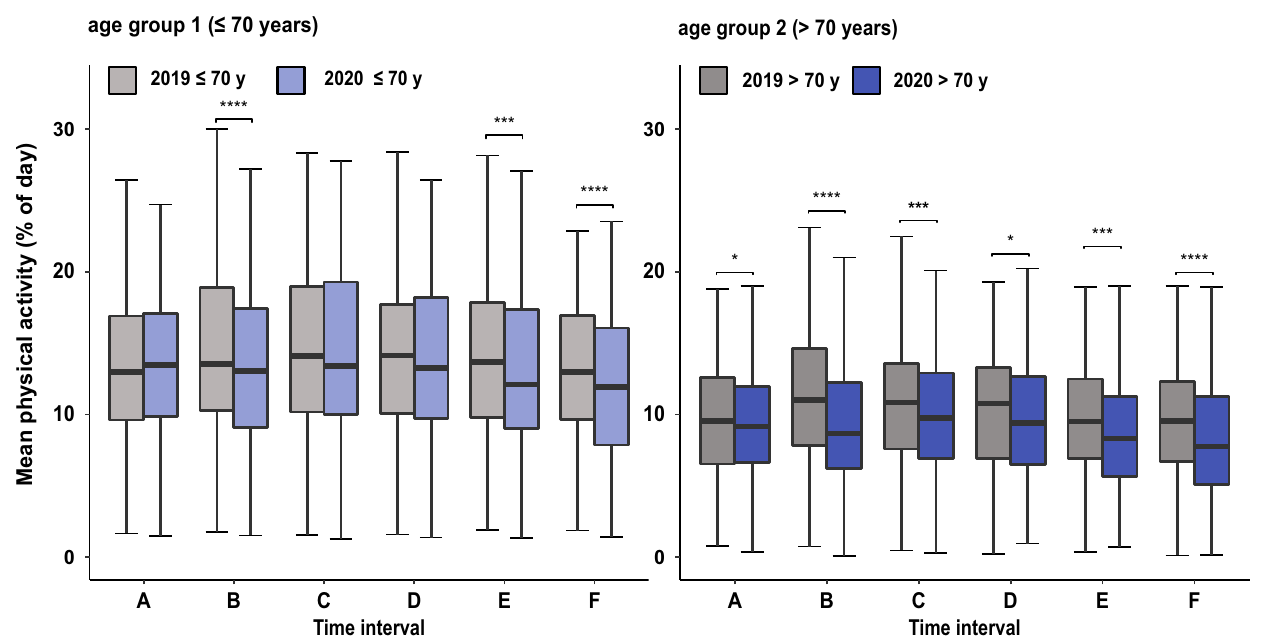
Fig 5. Comparison of physical activity of corresponding time intervals in 2019 and 2020 by age groups. Box-Whisker plots of mean physical activity. Age group 1 < 70 years, age group 2 � 70 years. Intervals A to F, marking time intervals with different levels of health restrictions in 2020 are annotated and transferred identically to the year 2019. Significant changes in physical activity between corresponding intervals of 2019 and 2020 are annotated ( � = p < 0.05, �� = p < 0.01, ��� = p < 0.001, ���� = p < 0.0001).